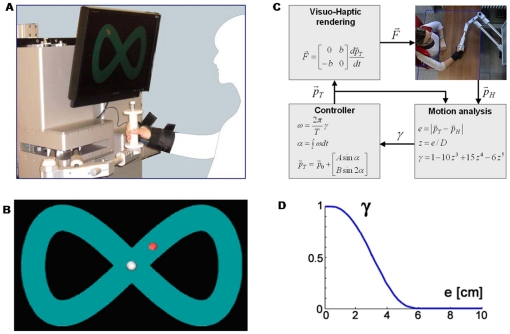
Experimental setup.
A: Haptic manipulandum BdF used in the experiments. B: Dynamic visual display. The red circle identifies the position of the target and the white circle the position of the hand; both have a 2 cm diameter. The eight-shaped pathway is displayed in the background for one group of subject. For the other group the background is uniformly black. The ideal eight-shaped path is ±15.7 cm wide and ±9 cm high; total length is equal to 102 cm; the nominal circling period is 8 s. C: Real-time flow of information among the four main modules of the robotic manipulandum (BdF haptic manipulandum; Motion analysis and performance evaluation; Task controller; Force-field generator); : position vectors of the target and the hand, respectively; D = 6 cm: threshold for the tracking error e; : target speed modulating function; T = 8s: nominal circling time; b = 100 N/m/s: viscous coefficient of the curl field . D: Profile of the target speed modulating gain.